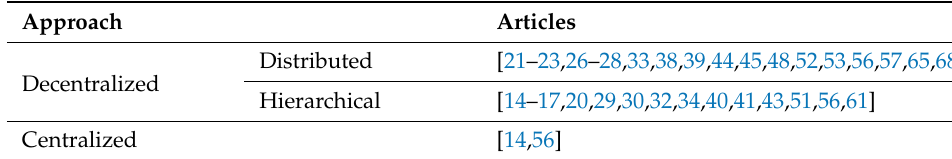
Table 2. TSO/DSO coordination